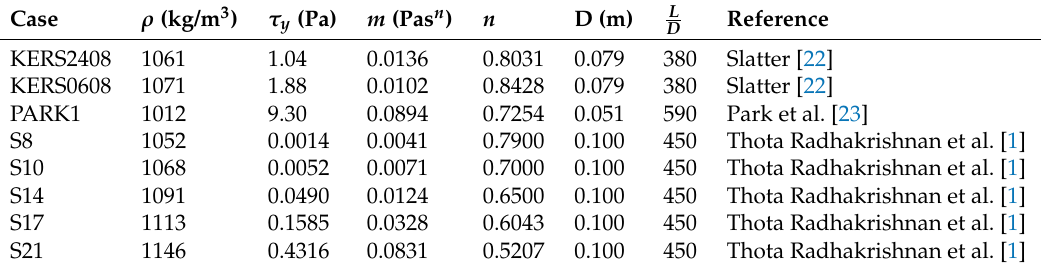
Table 1. The test-cases considered for this article. The first two are from Slatter [22], PARK 1 from Park et al. [23] and the last five belong to experimental data supplied by the co-authors